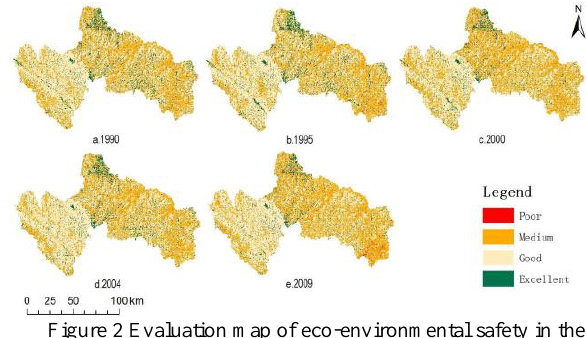
Figure 2 Evaluation map of eco-environmental safety in the study area from 1990 to 2009